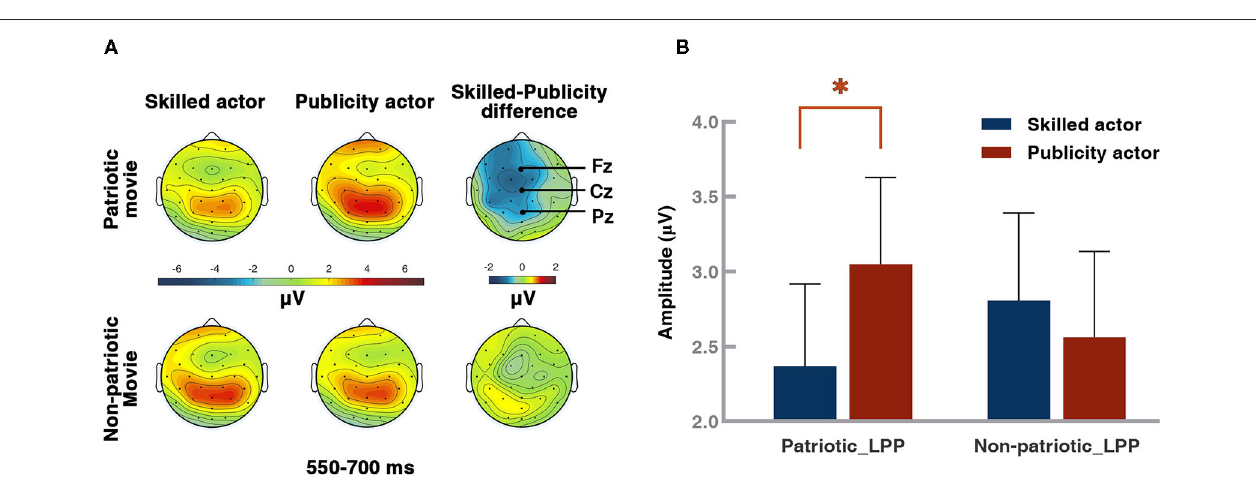
Frontiers in Psychology |